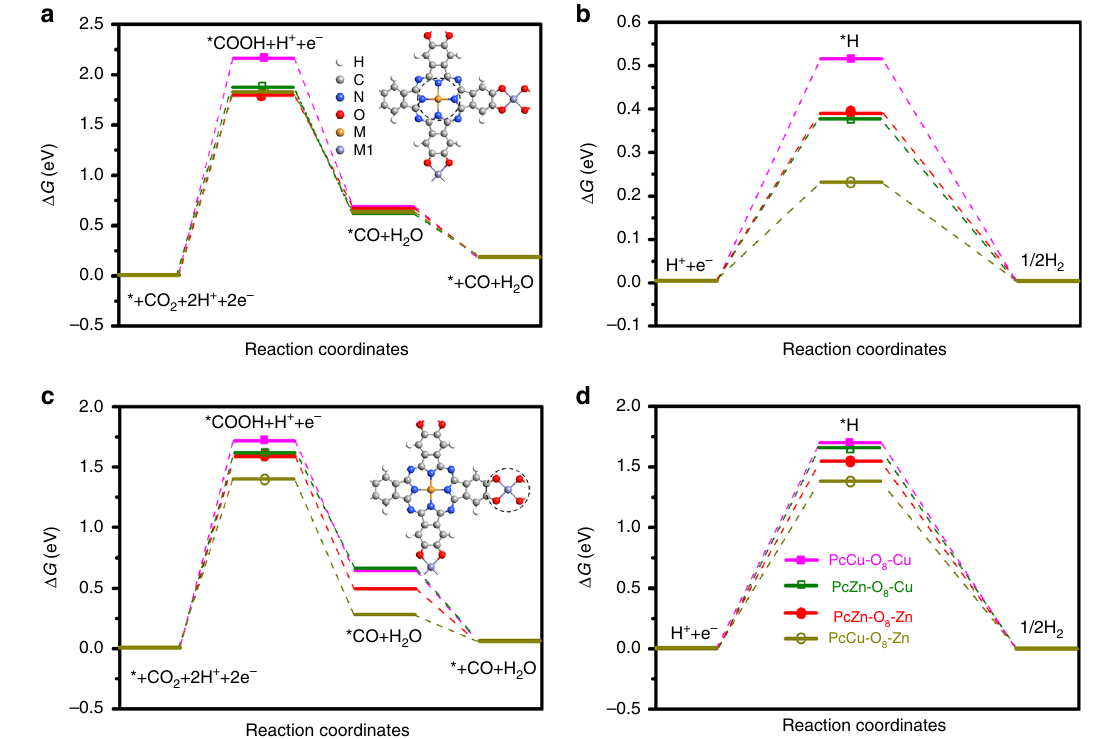
Fig. 1 DFT calculation of CO 2 RR. a , b Free energy pro fi les of CO 2 RR and HER on MN 4 units of PcM-O 8 -M1 at U = 0.0 V, respectively. Inset in ( a ): atomistic structure of PcM-O 8 -M1. The dashed circle indicates the catalytic active area with MN 4 units. c , d Free energy pro fi les of CO 2 RR and HER on M1O 4 units in the PcM-O 8 -M1 at U = 0.0 V, respectively. Inset in ( c ): atomistic structure of PcM-O 8 -M1. The dashed circle indicates the catalytic active area with M1O 4